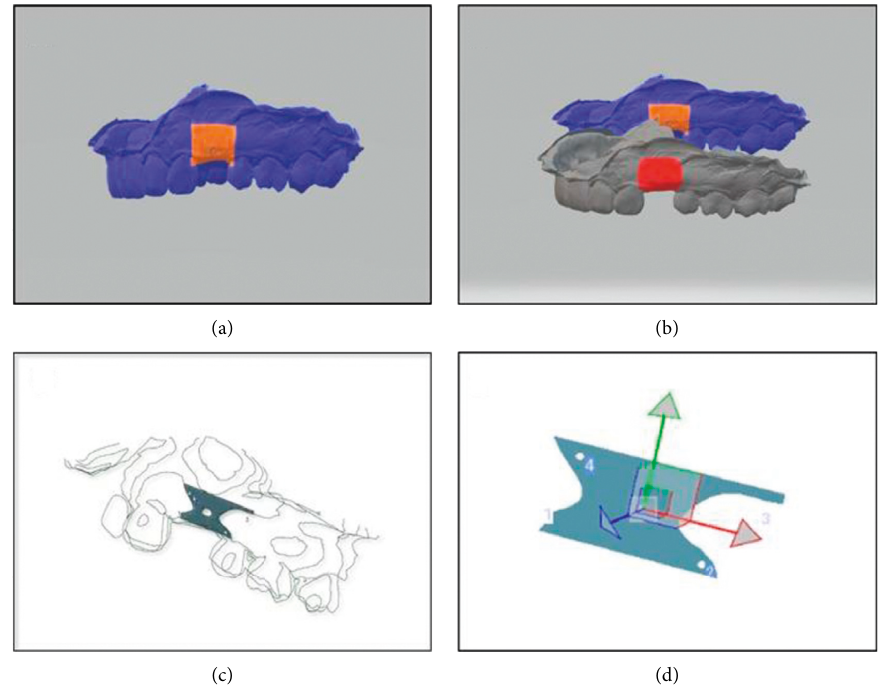
Figure 4: Digital models showing volumetric analysis. (a) Digital model showing determination of the fixed points on the scanned cast to determine the pontic site, (b) digital models showing the alignment of the two pontic sites of the preoperative cast (baseline) and cast poured 3 months post surgically, (c) digital diagram showing volumetric changes calculation in superimposed pontic sites, and (d) digital model showing Isolated section of the pontic site to calculate the area and volume of the